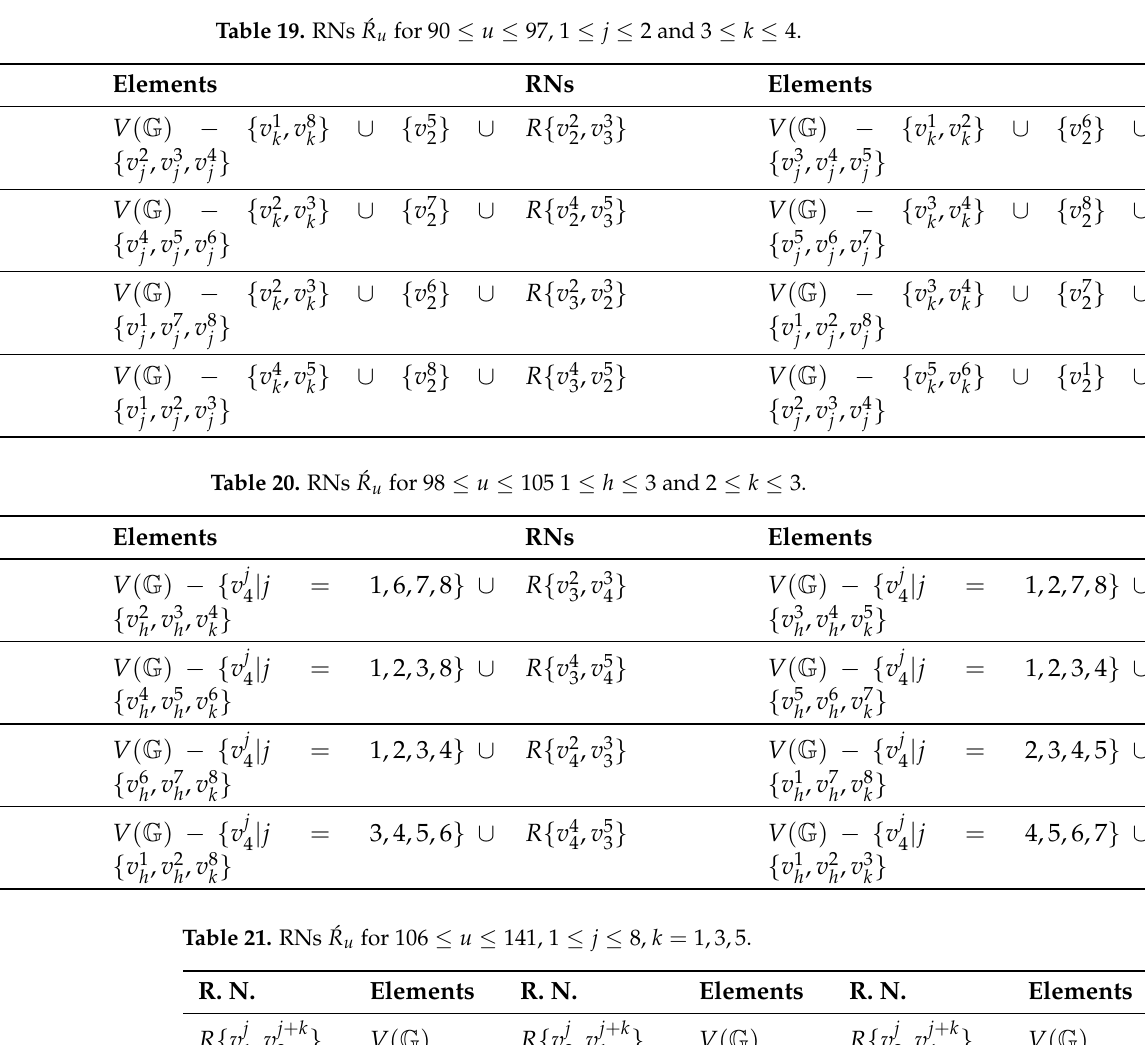
Table 19. RNs ´ R u for 90 ≤ u ≤ 97, 1 ≤ j ≤ 2 and 3 ≤ k ≤ 4.